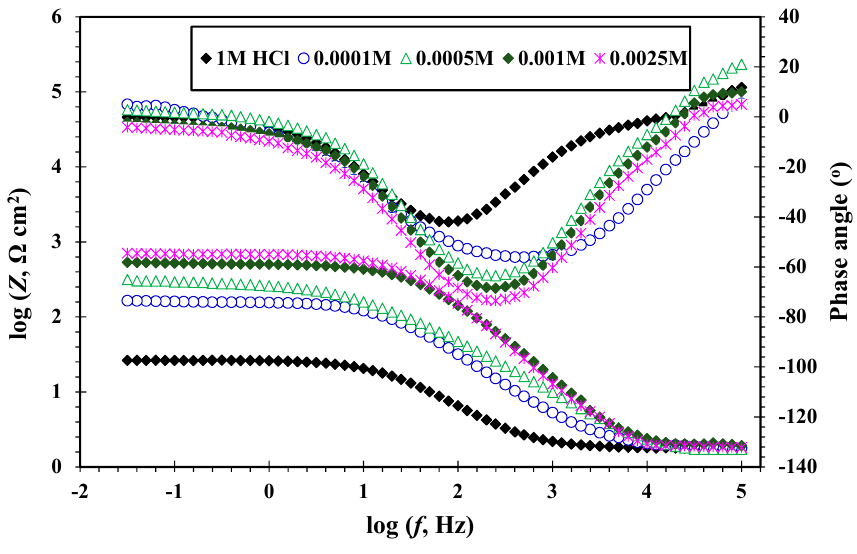
Figure 12. Bode plots for MS in 1 M HCl in the absence and presence of different concentrations of CGSES16 at 20 °C.